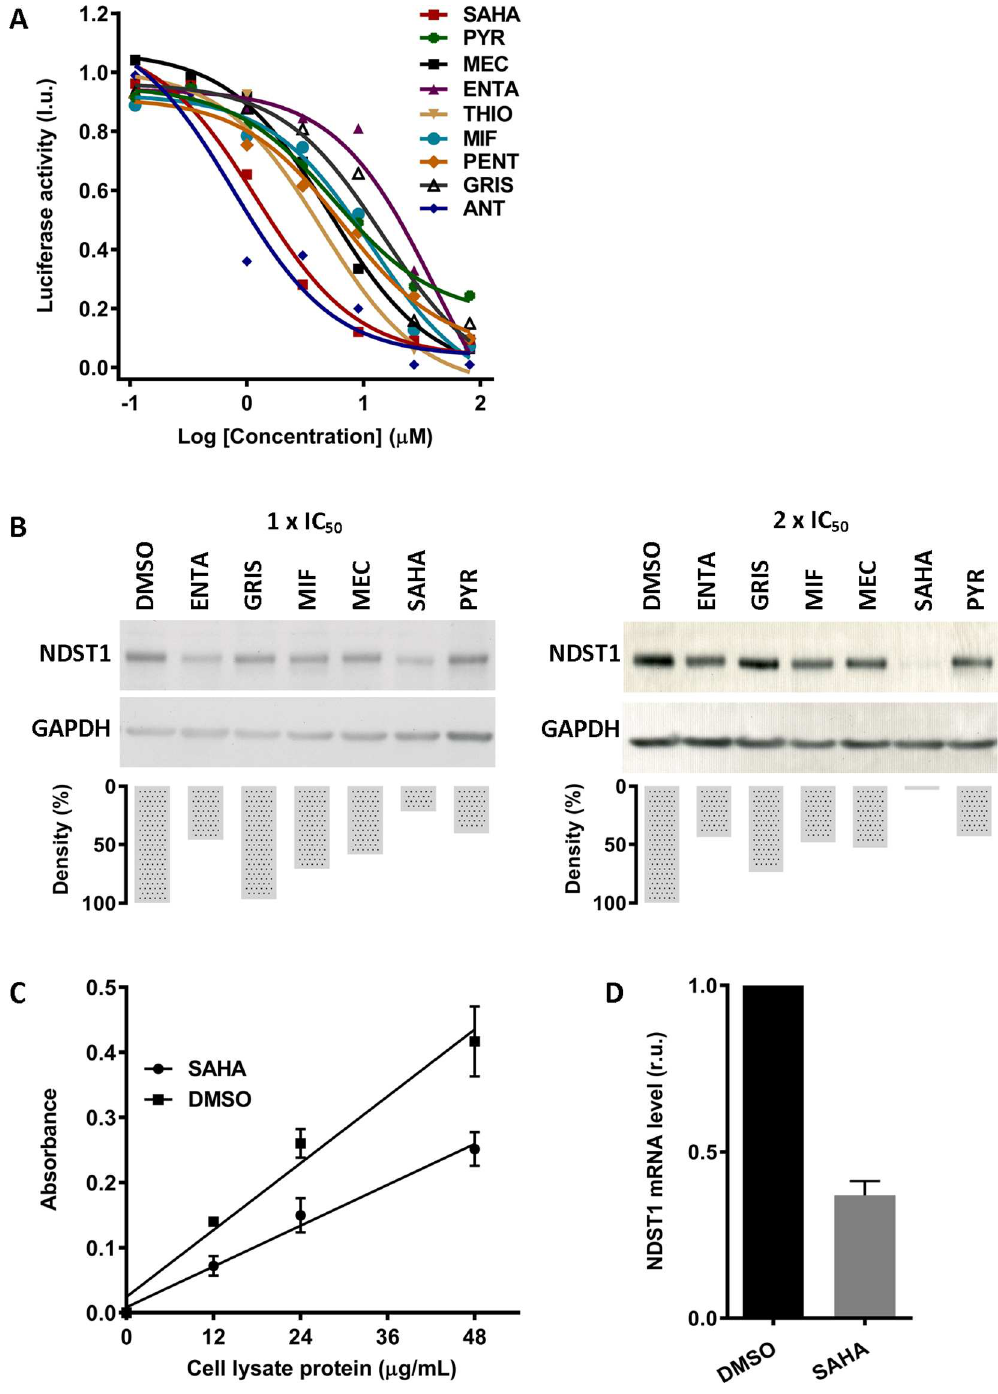
Fig 4. Secondary screening and ‘hit’ validation. (A) Dose-dependent inhibitionof the NDST1 promoter activity. HeLa cells stably expressing NDST1 promoter were treated with serially diluted potential NDST1 repressors. Dose-response curves were producedfrom 9 out of 10 drug candidates. Experiments were performed in singles. (B) Western blot densitometryanalysis of NDST1 protein expressionafter treatment with selected potential NDST1 repressors. Normal human fibroblast cells were treated with potential NDST1 inhibitorsat their calculated 1x IC 50 or 2x IC 50 . The effect of the compoundon the NDST1 expressionwas evaluated using densitometry analysis of NDST1 band normalized to its corresponding GAPDH band. Distinct decrease in NDST1 expression was observed for 2x IC 50 SAHA treatment. (C) ELISA assay of total NDST activity in normal human fibroblast